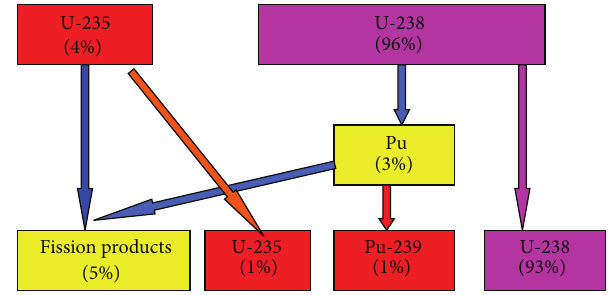
Figure 1: Evolution of fuel from a nuclear reactor during an operating